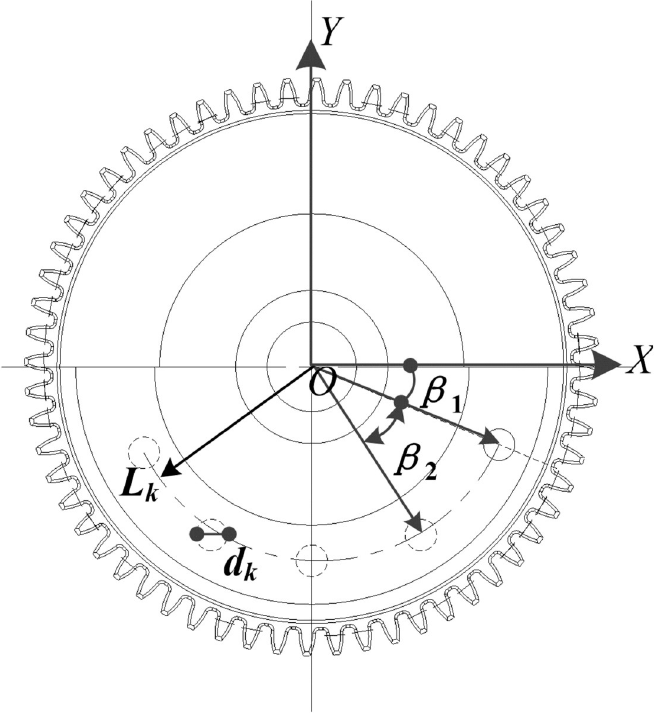
Fig 6. Plane characteristics of weight-reducing hole